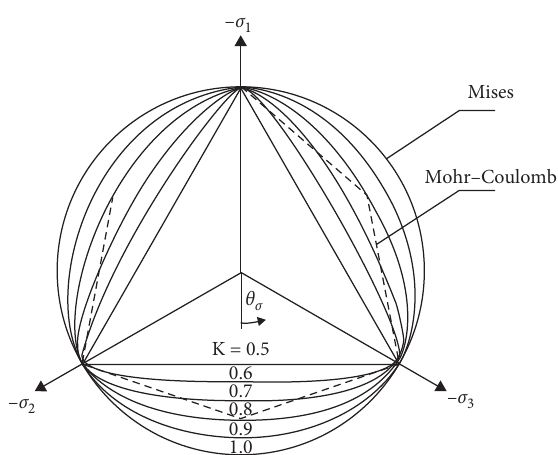
Figure 1: The Willam–Warnke failure criterion in the deviatoric plane with different K